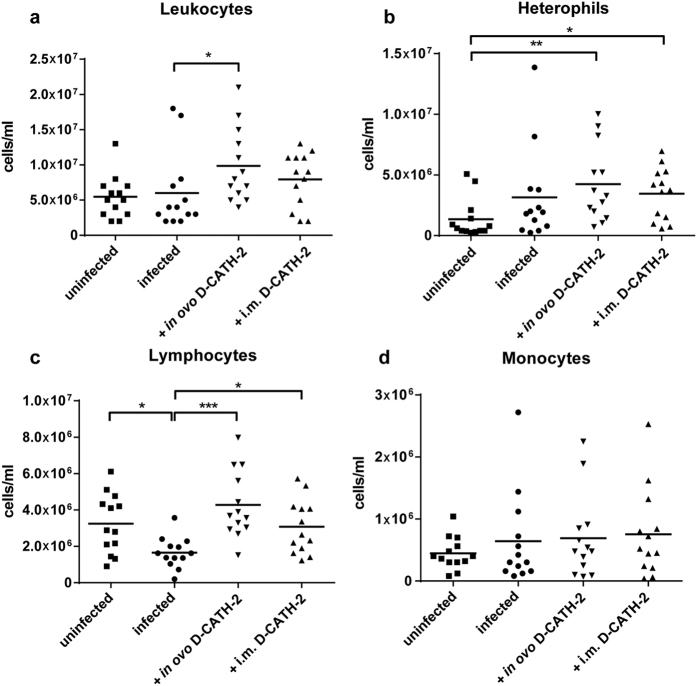
Leukocyte counts in peripheral blood at 2 days post E. coli challenge based on blood smear analysis. (a) leukocytes, (b) heterophils, (c) lymphocytes, (d) Monocytes. Data were analyzed by one-way ANOVA with a Tukey post-hoc test. *p < 0.05, **p < 0.01, ***p < 0.001.